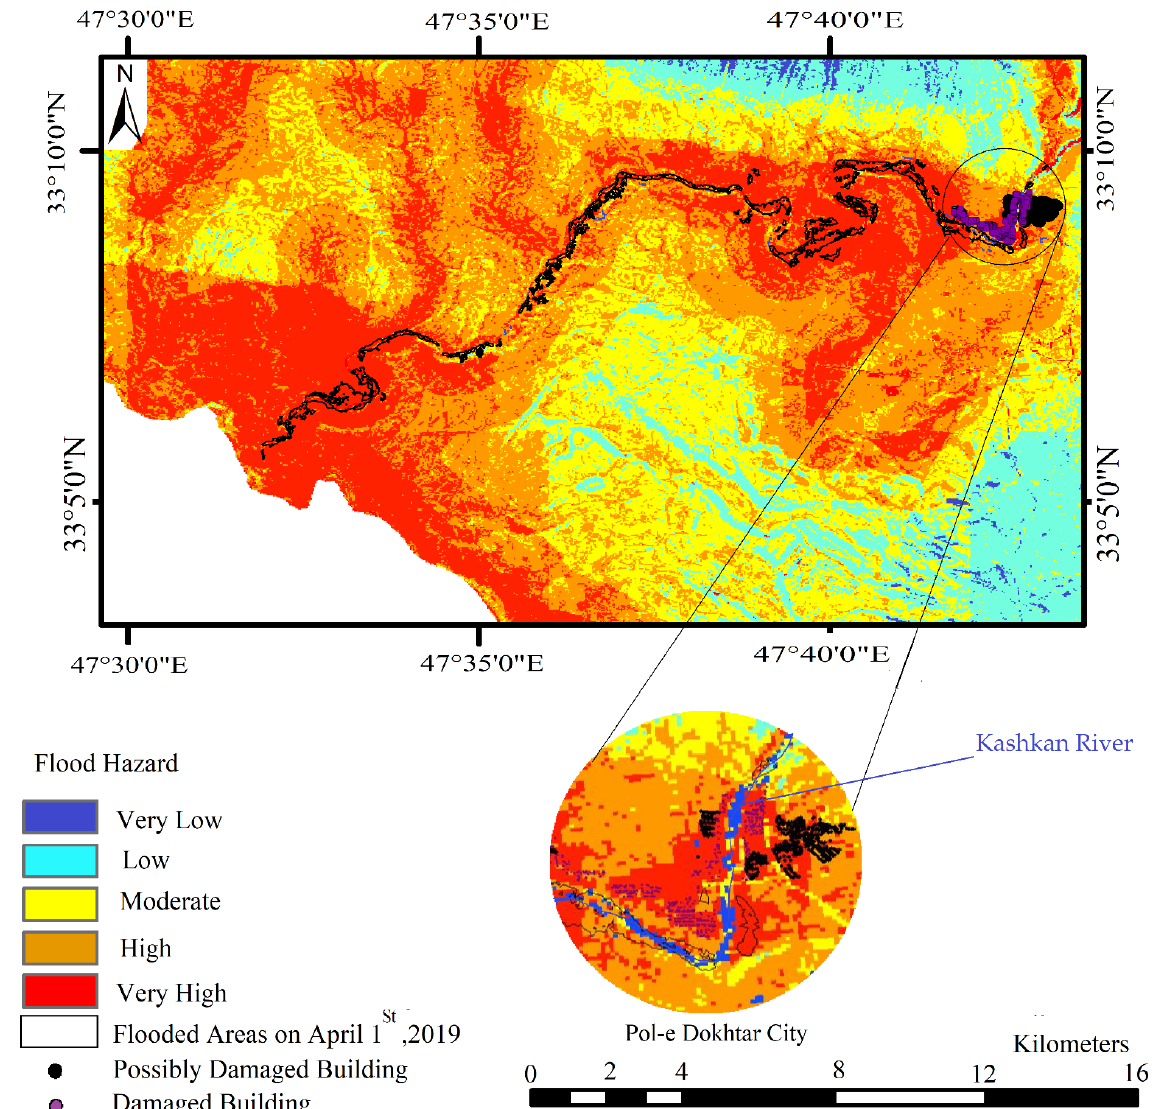
Figure 8. The produced flood risk map of Pol-e Dokhtar County superimposed by the detected flood areas from multi- temporal Sentinel-1 images (black boundary), and affected buildings/properties by the flood (purple dots).